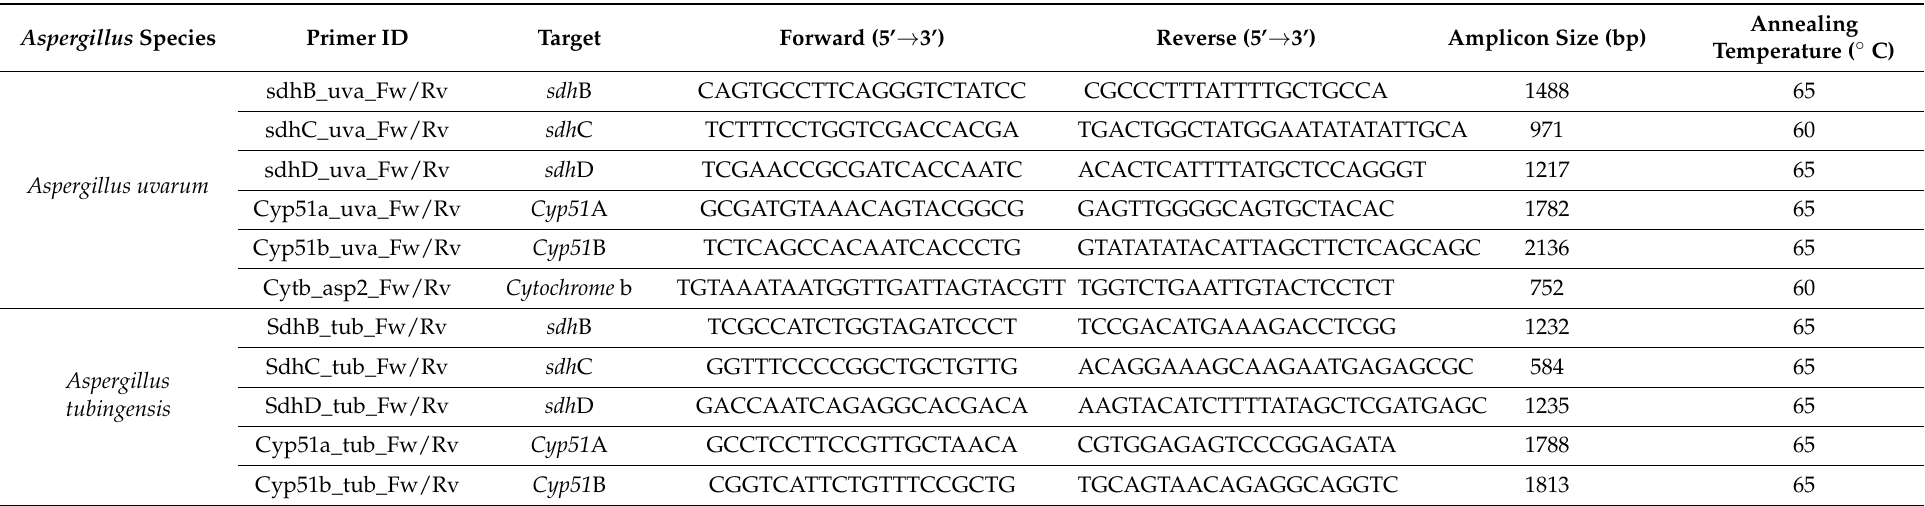
Table 1. Designed primer pairs for the amplification and the sequencing of PCR products for the sdhB , sdhC , sdhD , Cyp51A , Cyp51B , and cytb subunits of the Aspergillus uvarum and A. tubingensis